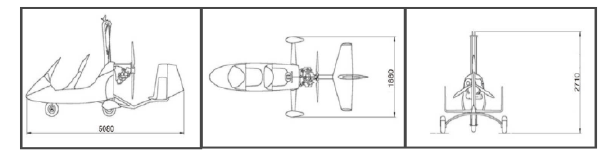
Figure 2. Position of two IMUs shown within the blue circles.